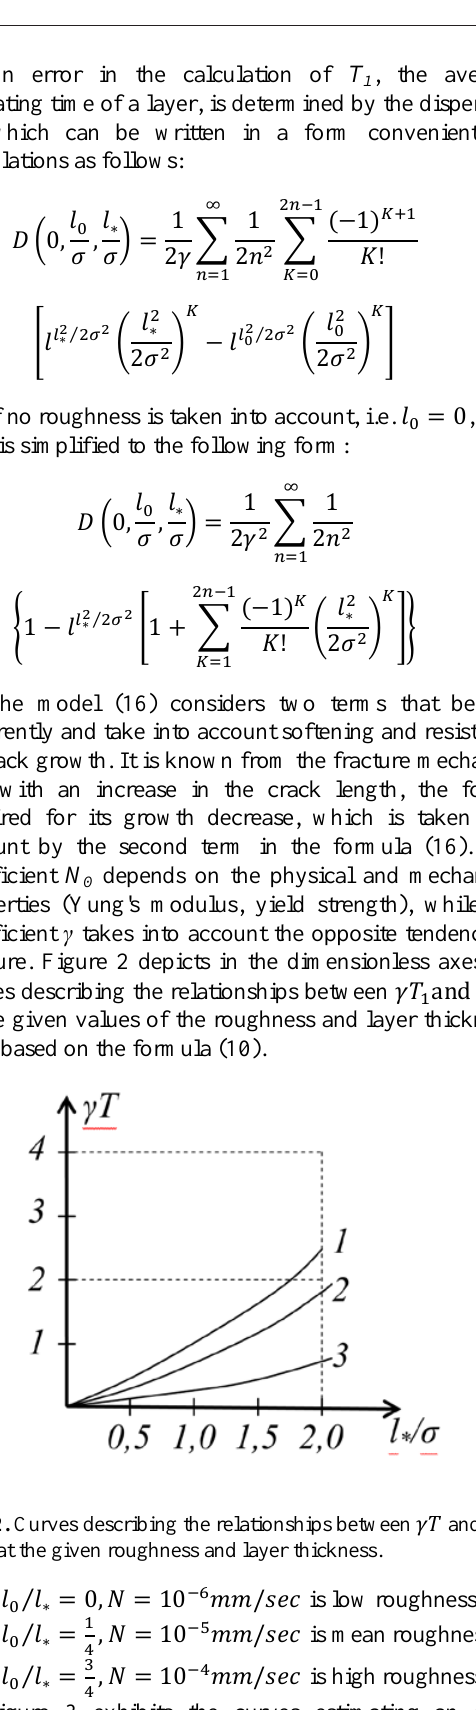
Figure 3 exhibits the curves estimating an error (dispersion), also built based on the formula